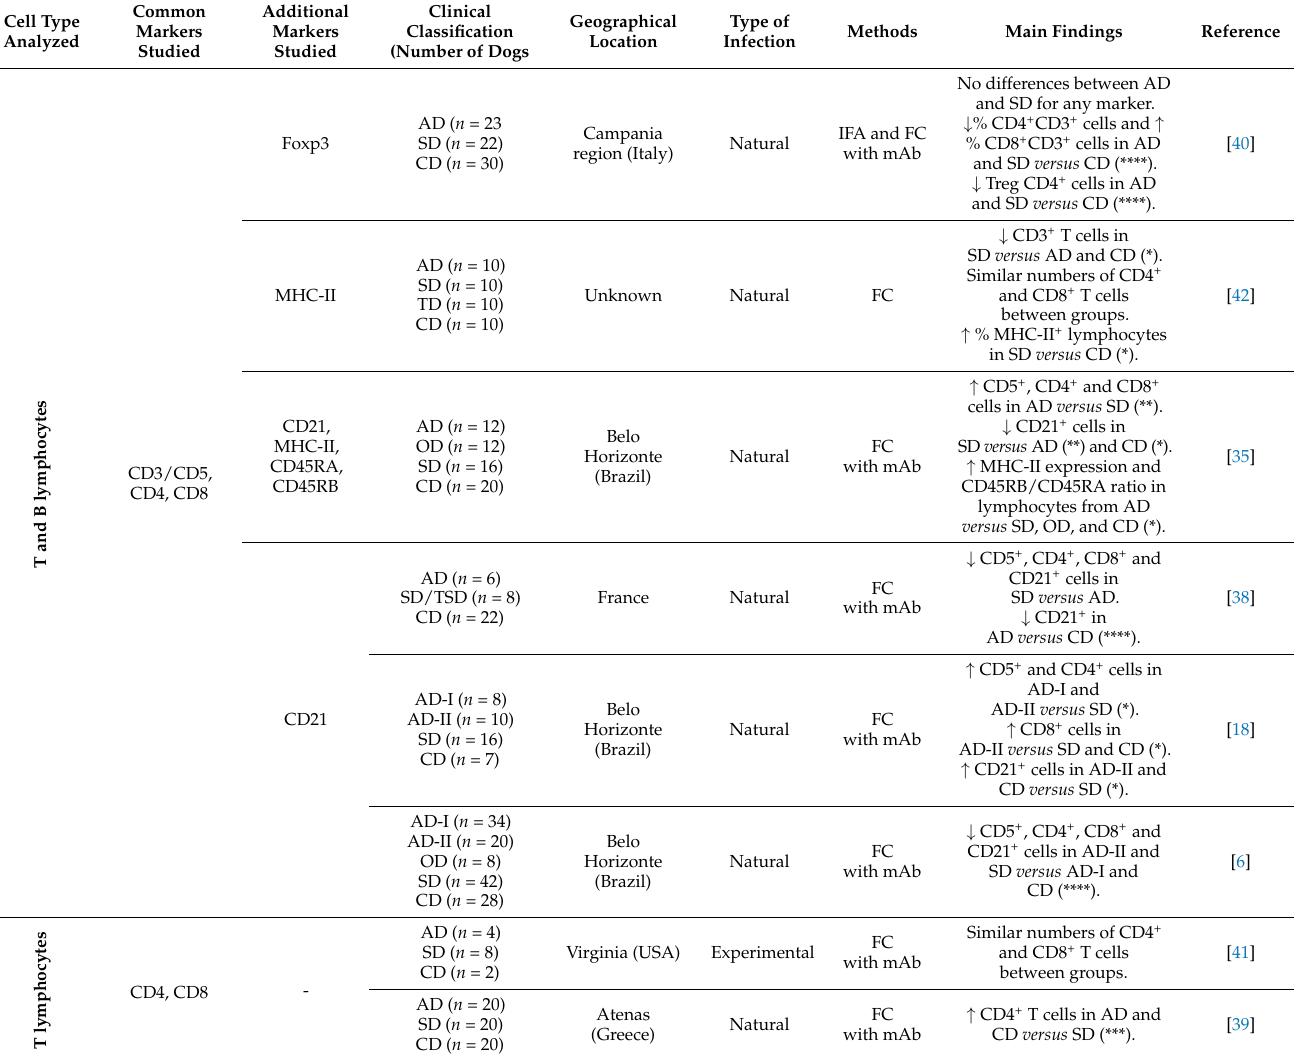
Table 1. Studies that analyzed the immune profiles of PBMCs from infected and control